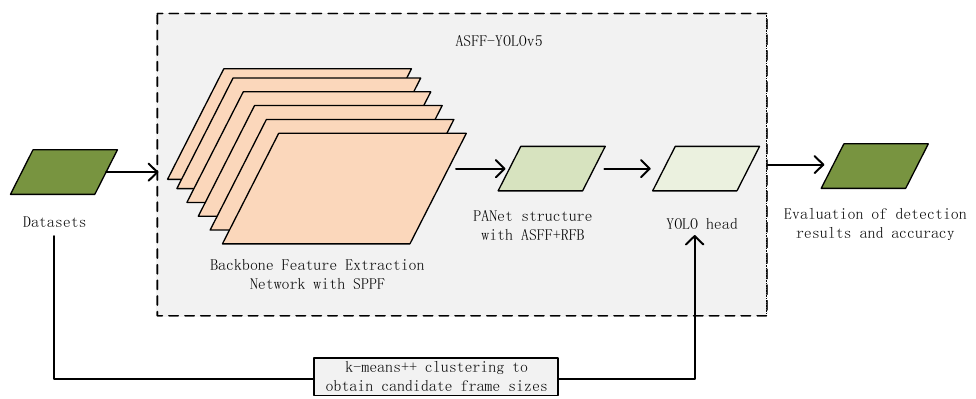
Figure 2. Flow chart of the proposed method.